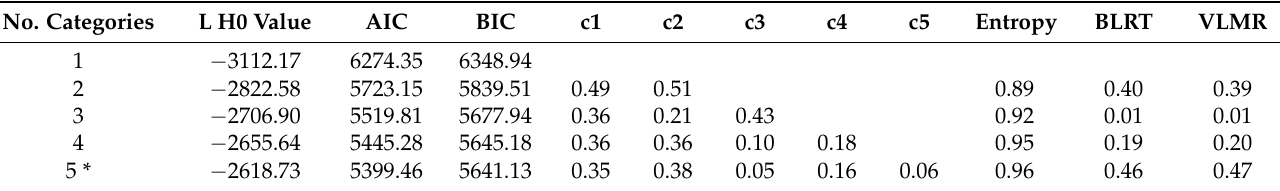
Table 3. Results of the latent profile